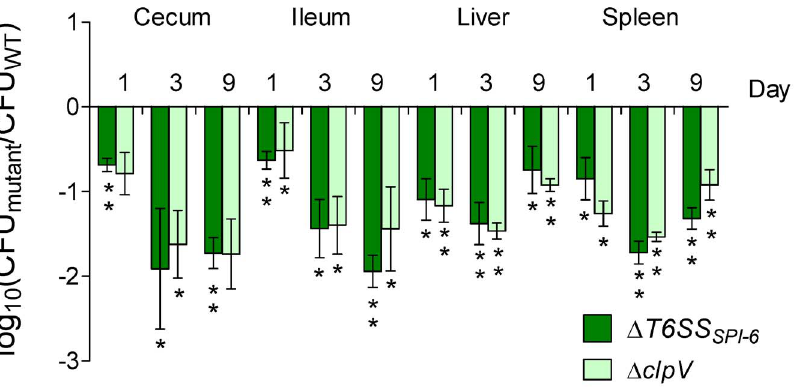
Figure 2. Invivo competition between D T6SS SPI-6 and D clpV deletion mutants and the wild type S . Typhimurium strain 14028 s. Fifteen four-day-old White Leghorn chicks were infected intragastrically by gavage with 10 9 CFU of a mixture at a 1:1 ratio of the respective mutant strain and the wild type S . Typhimurium 14028 s. At 1, 3 and 9 days post-infection groups of 5 chicks were sacrificed and organs were excised, homogenized, and serially diluted to determine bacterial loads. Bars represent the geometric mean of the log ratio of the mutant CFU/wild type CFU, normalized to the inoculum ratio. Error bars denote standard error. Statistical significance was determined using a two-tailed Student’s t test, and asterisks indicate that normalized output ratios were significantly statistically different from the equivalent ratio in the inoculum (* P , 0.05;